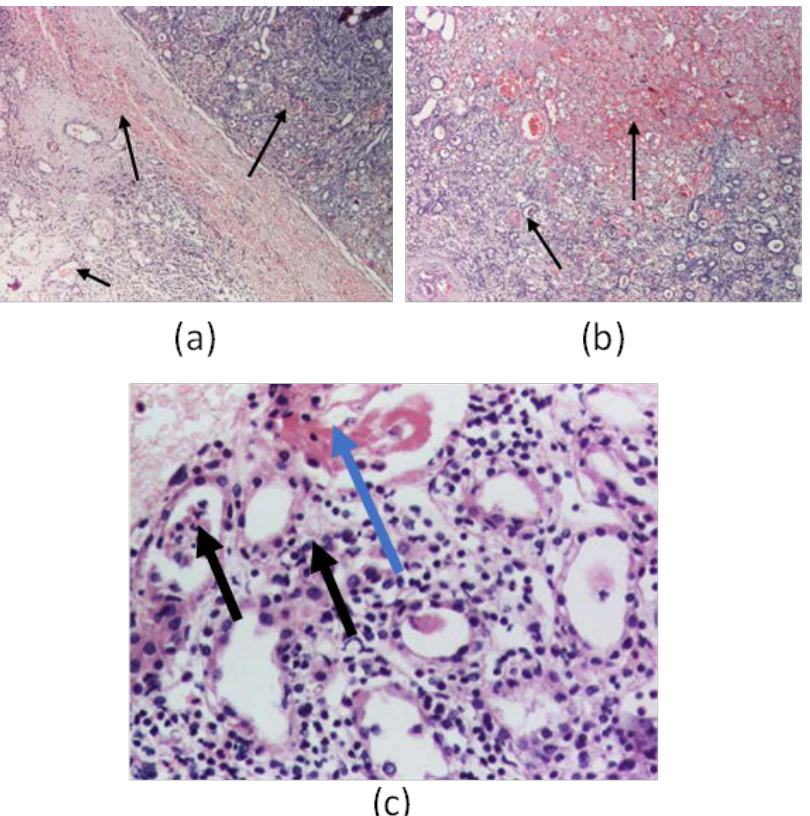
Figure 1. Kidney biopsy: ( a )—Hematoxylin-Eosin (HE) coloration in optic microscopy (OM) ( × 40) showing multifocal interstitial hemorrhages in the subcapsular areas (black arrows); ( b )—HE coloration in OM ( × 40), showing multifocal interstitial hemorrhages (black arrows); ( c )—HE coloration in OM ( × 200), showing interstitial nephritis infiltrates with polymorphonuclear cells and eosinophils in the renal interstitial and tubules (black arrows); renal tubules with fibrino-leukocyte cylinders—(blue arrow).